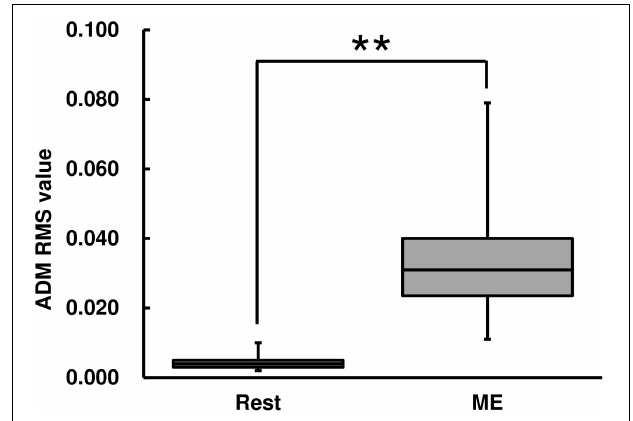
FIGURE 3 | Root mean square (RMS) value of abductor digiti minimi (ADM) muscle for the ME task. RMS values are represented using a box and whisker plot, with the median shown as the middle horizontal line, the upper and lower quartiles displayed as boxes, and the maximum and minimum represented as whiskers. The vertical axis shows the RMS value, and the horizontal axis shows the specific condition (Rest and ME). ** p < 0.01.